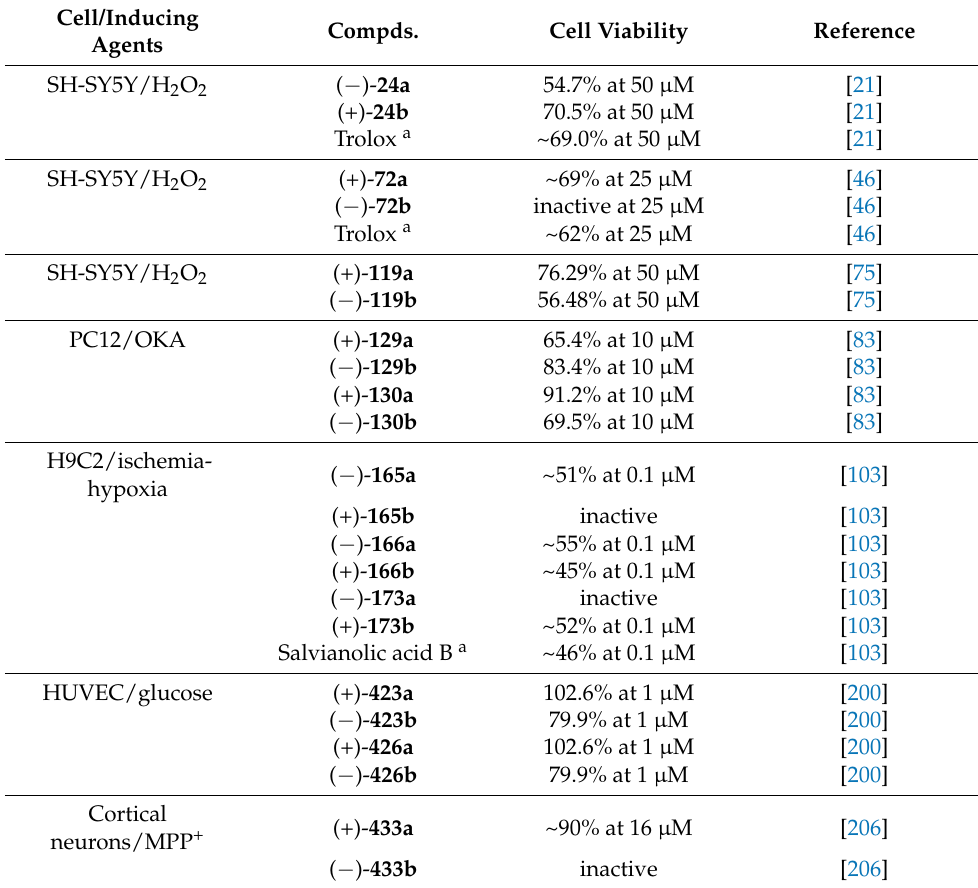
Table 8. Cell protective activities of